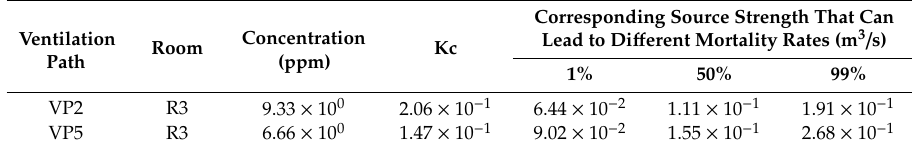
Table 4. The corresponding source strength calculated by the highest concentration room when the pollutant source is leaked at y = 0.5